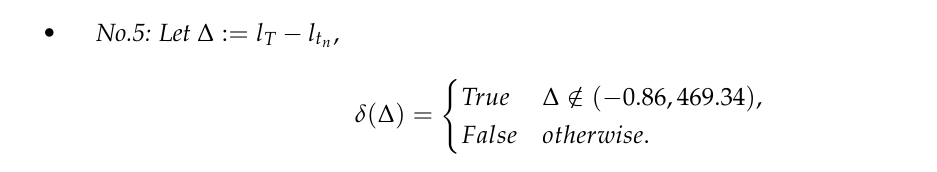
Table 2. Correlation coefficient of predicted and actual illuminance values assessed on the test data using the models trained with varying machine learning model and window size.